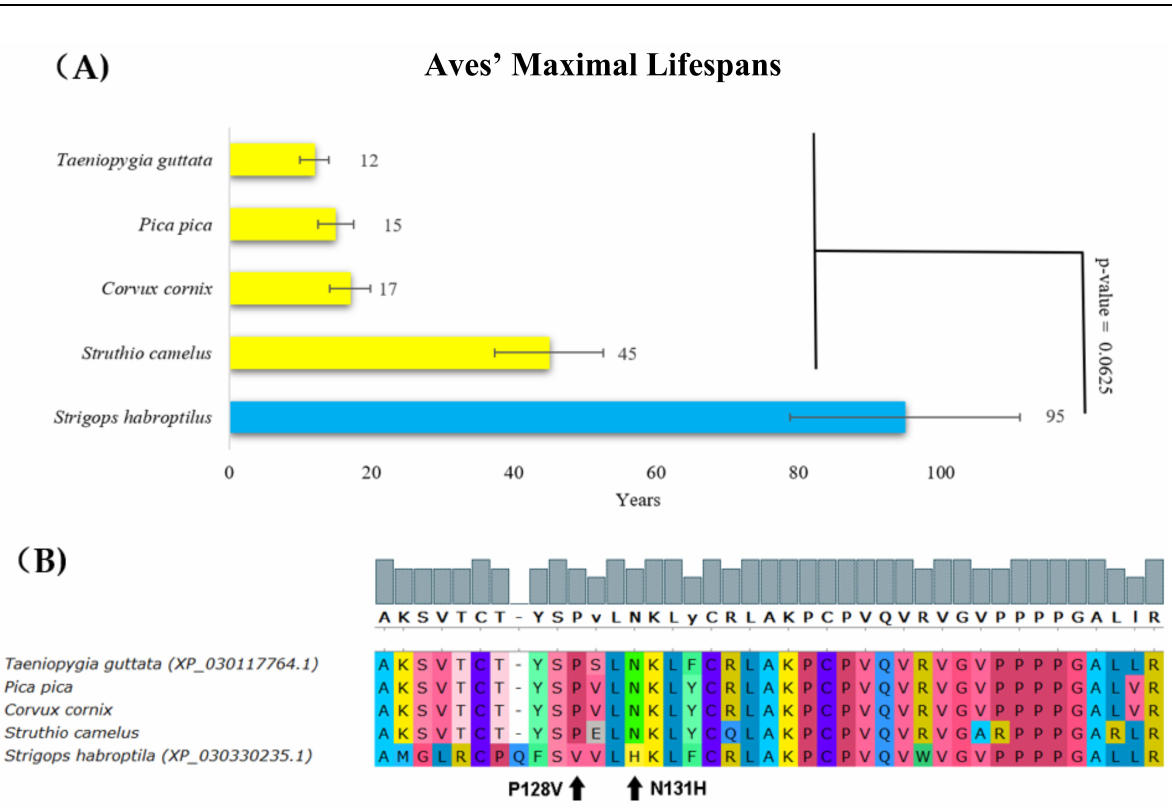
Figure 3. Lifespans of species in the Aves order and the corresponding p53 sequence changes. ( A ) Comparison of Aves’ maximal lifespans in years. The kakapo’s ( Strigops habroptila ’s) maximal lifespan was more than twice the maximal lifespan of other Aves (Wilcoxon one-sided signed-rank test). ( B ) Multiple protein alignments representing the partial p53 core domain of the accessible Aves sequences. Sequences of all avian p53 homologs were determined using transcriptomic data from the SRA Archive, except for Strigops habroptila , where the p53 sequence was known (XP_030330235.1). The methods and color schemes are the same as in Figure